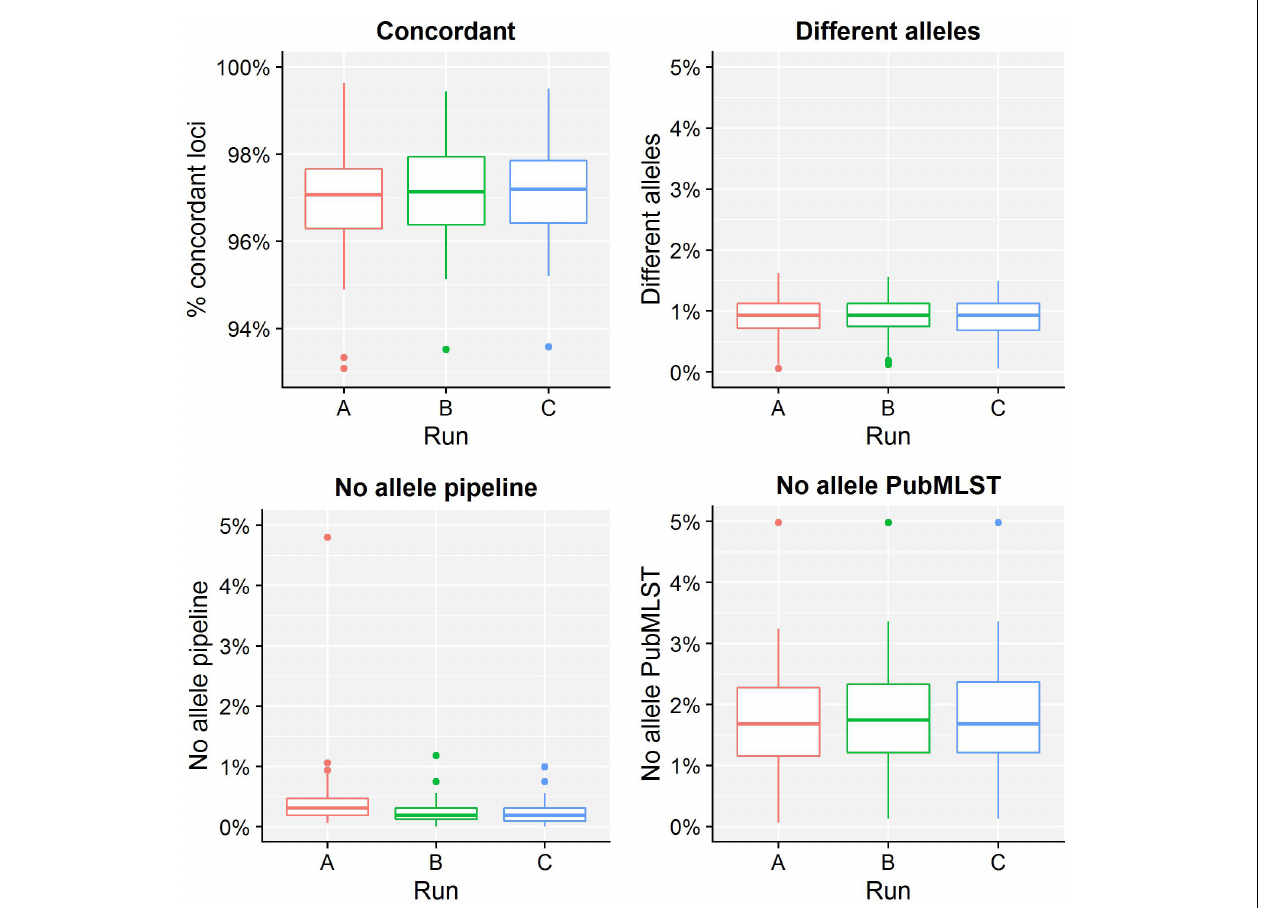
FIGURE 3 | Database standard results of the sequence typing assay for the core validation dataset. The abscissa depicts the sequencing run, while the ordinate represents the percentages of cgMLST loci as indicated by the title above each graph. Each sequencing run is presented as a boxplot based on 67 samples (see the legend of Figure 2 for a brief explanation). The upper left graph depicts the percentage of concordant cgMLST loci, i.e., where our workflow identified the same allele as the database standard, which were classified as TPs. Note that the ordinate starts at 93% instead of 0% to enable illustrating the results more clearly. All other cases were classified as FNs, and encompass three categories. First, the upper right graph depicts the percentage of cgMLST loci for which our workflow detected a different allele than present in the database standard. Second, the bottom left graph depicts the percentage of cgMLST loci for which our workflow did not detect any allele but an allele was nevertheless present in the database standard. Third, the bottom right graph depicts the percentage of cgMLST loci for which our workflow detected an allele but for which no allele was present in the database standard. Most FNs are explained by no information being present in the database standard, followed by an actual mismatch, and only few cases are due to our workflow improperly not detecting an allele. See also Supplementary Table S10 for detailed values for all samples and